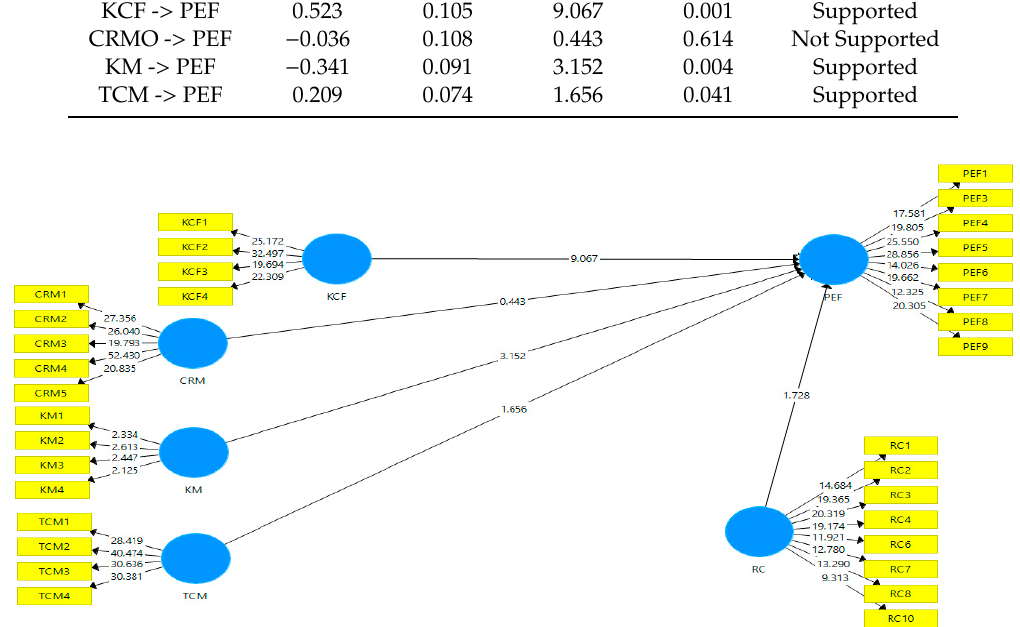
Figure 3. The structural model.